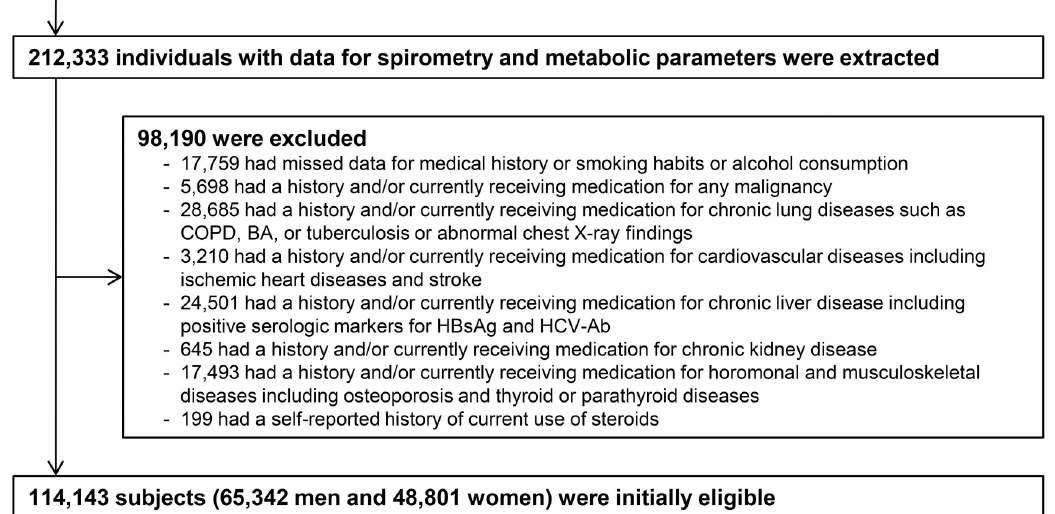
Fig 1. Selection of study participants. BA = bronchial asthma; COPD = chronic obstructive pulmonary disease; HBsAg = hepatitis B virus surface antigen; HCV-Ab = hepatitis C virus